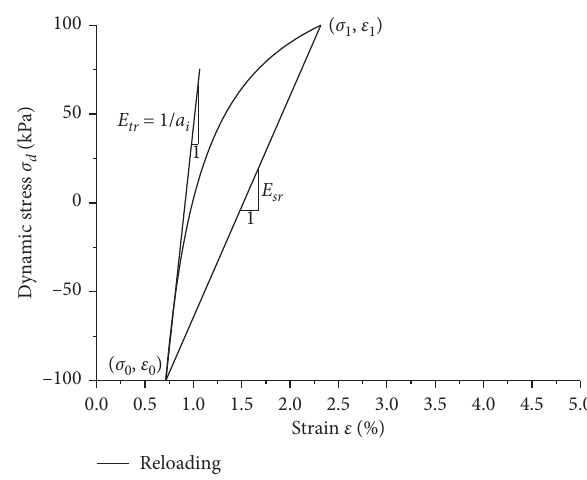
Figure 7: Significance of the parameter a